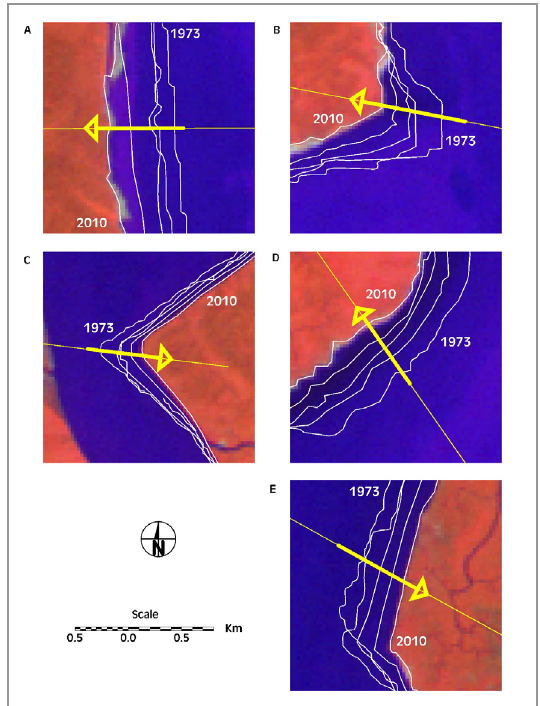
Figure 3. Demonstration of time series coastal erosion (1973-2010) in the western part of Sundarbans (Bangladesh